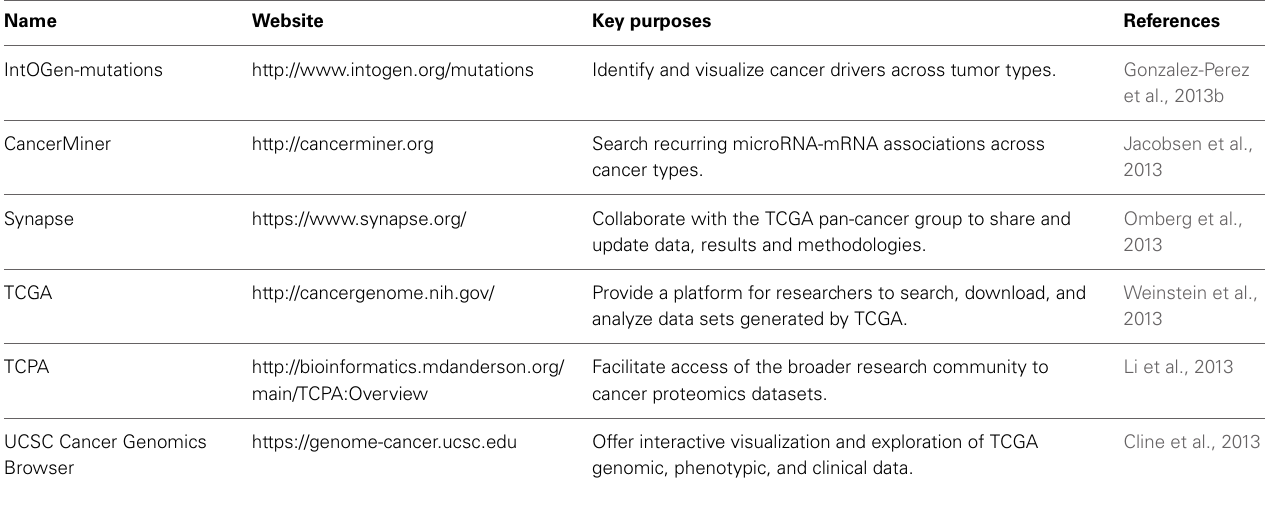
Table 2 | Brief summary of useful webserver or database for pan-cancer